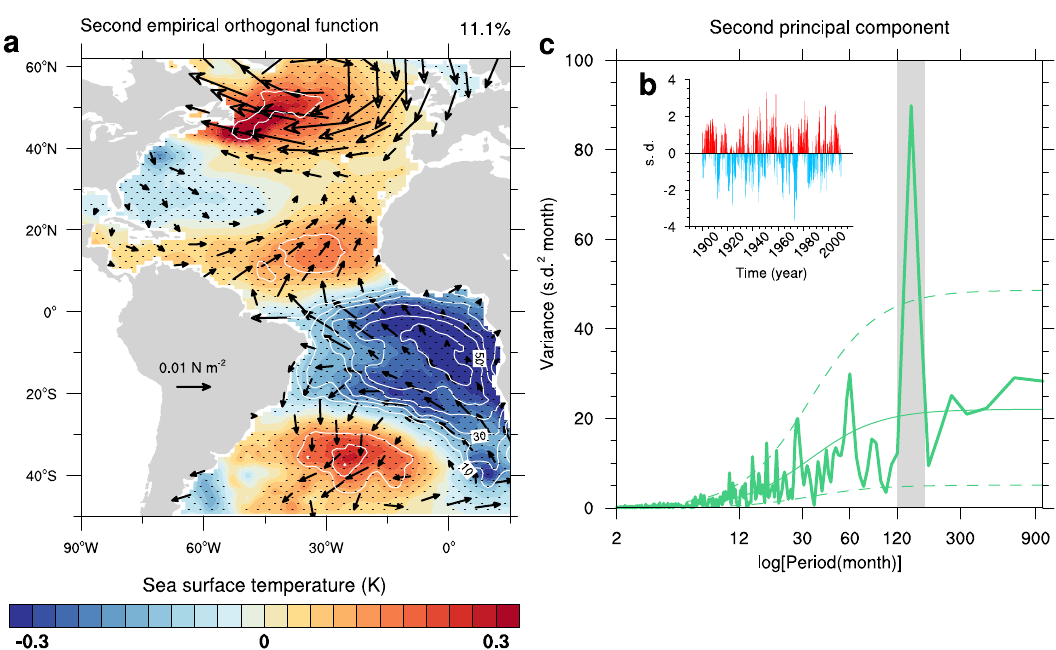
Fig. 2 EOF2 of monthly SST anomalies in the Atlantic. a SST (color-scale) and wind stress anomalies (arrows, only statistically signi fi cant vectors are shown) regressed onto the normalized SST PC2 time series. The stippling in ( a ) denotes statistical signi fi cance at 95% con fi dence level. b Time evolution of the SST PC2 and ( c ) its spectrum (thick, solid curve); the associated fi rst-order autoregressive spectrum (thin, solid curve) and the 95% con fi dence bounds (thin, dashed curves). The grey vertical bar shows the 10 – 15 years periodicity band.